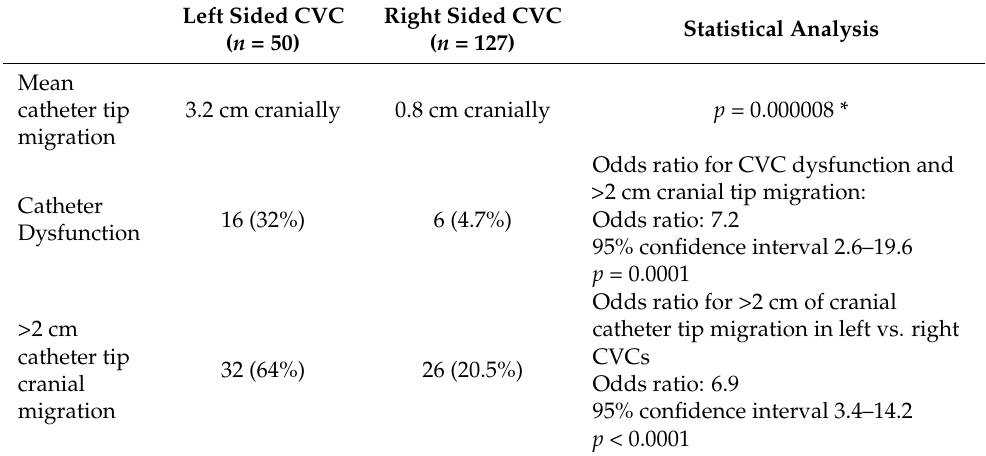
Table 2. Mean migration, catheter dysfunction odds ratio, and odds ratio for >2 cm cranial migration for left vs. right sided